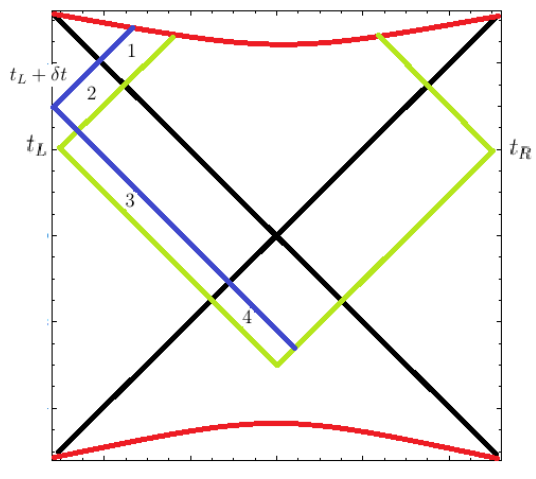
Figure 1 . Penrose diagram of an AdS-Schwarzschild black hole. The red lines represent the future and past singularities, while the black lines crossing the diagram are the event horizons. The area enclosed by the green lines and the future singularity is the WdW patch at times t L and t R . If t L is let to evolve in(cid:12)nitesimally the result is the patch shown in blue. This evolution then makes the patch to lose regions 3 and 4 while gaining regions 1 and